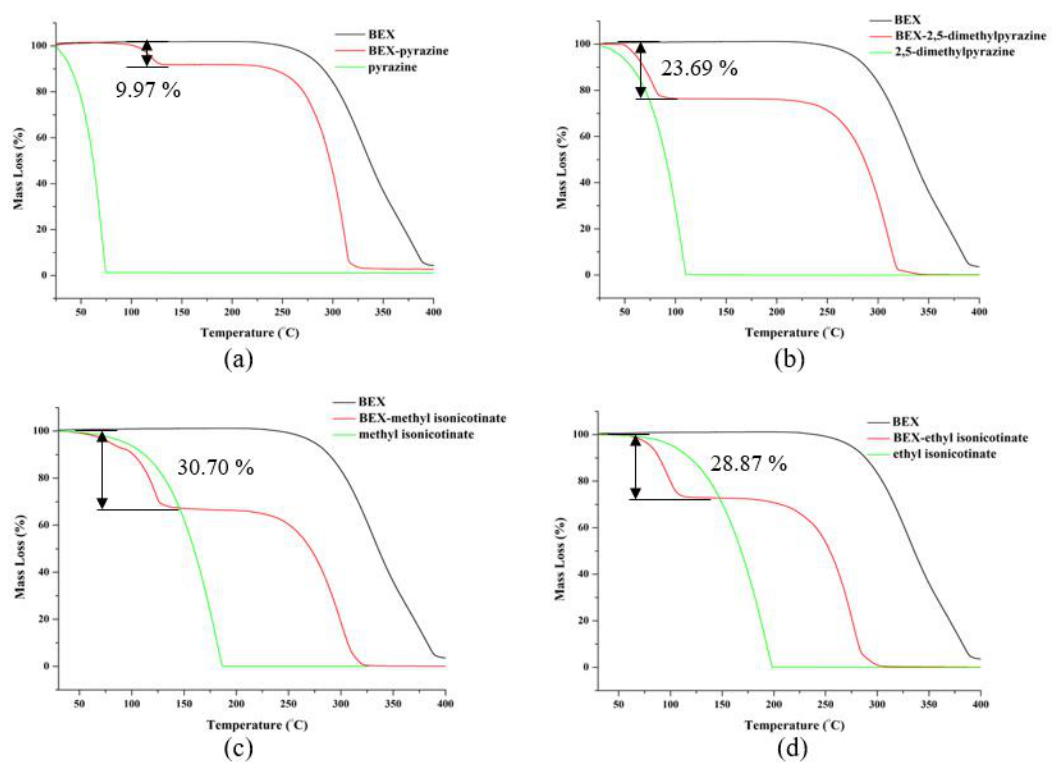
Figure 8. TG patterns of solid forms of BEX: ( a ) BEX-pyrazine, ( b ) BEX-2,5-dimethylpyrazine, ( c ) BEX-methyl isonicotinate, and ( d ) BEX-ethyl isonicotinate. ( c ) BEX-methyl isonicotinate, and ( d ) BEX-ethyl